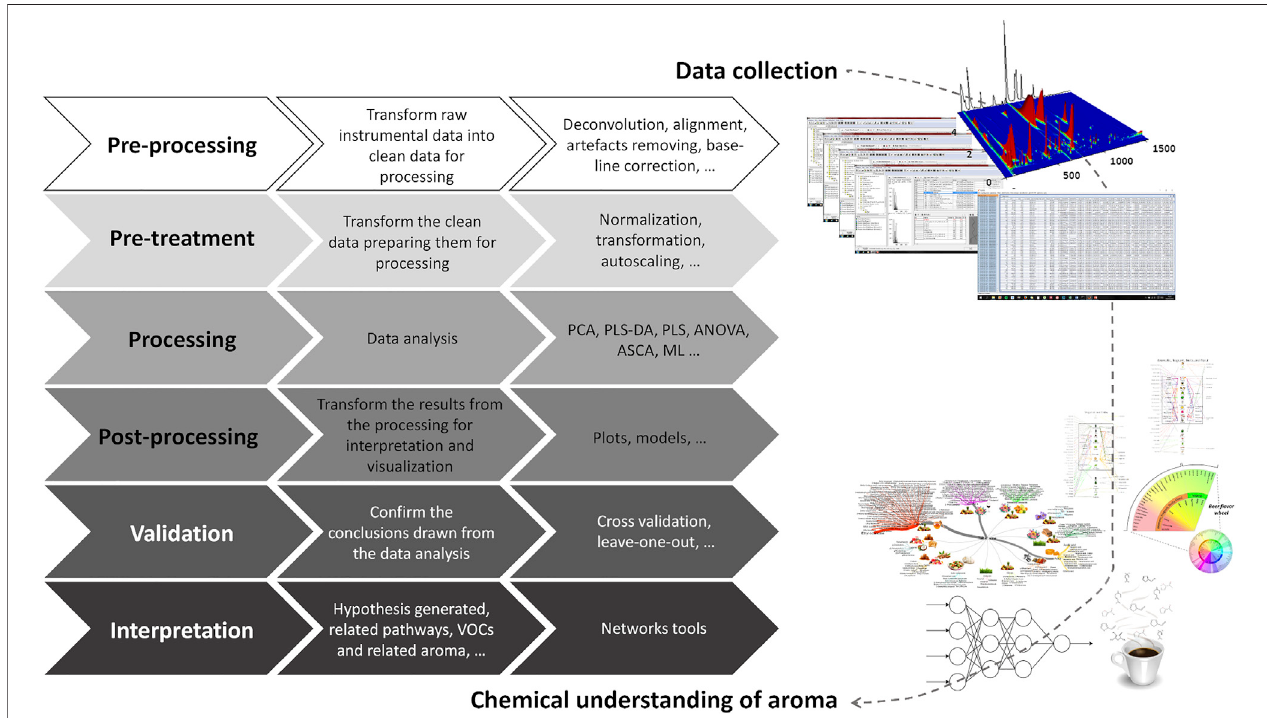
FIGURE 10 | From the instrumental data collection to the chemical understanding of aroma: step-by-step data transformation. PCA — principal component analysis; PLS-DA — partial least squares-discriminant analysis; ASCA — ANOVA-simultaneous component analysis; ML — machine learning.